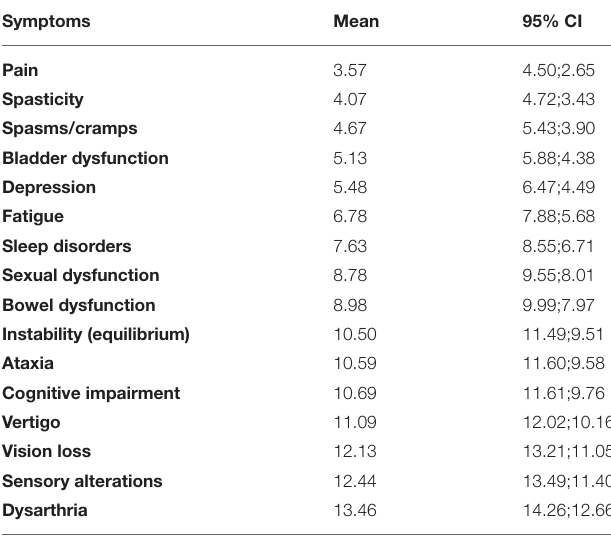
TABLE 1 | Treatment prioritization of multiple sclerosis